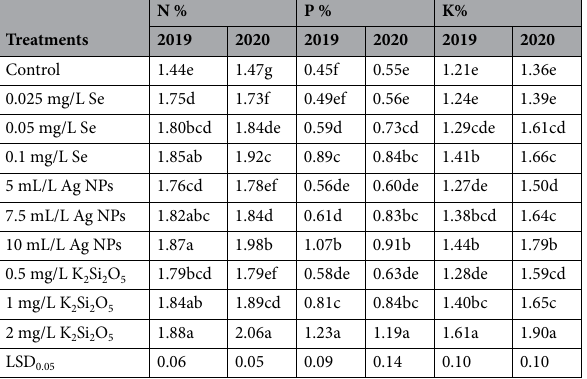
Table 9. Influence of the foliar spraying of Se, Ag NPs and K 2 Si 2 O 5 on the leaf composition from nitrogen, phosphorus, and potassium percentages of “Succary” pomegranate during 2019 and 2020 seasons. Means not sharing the same letter(s) within each column are significantly different at 0.05 level of significance.